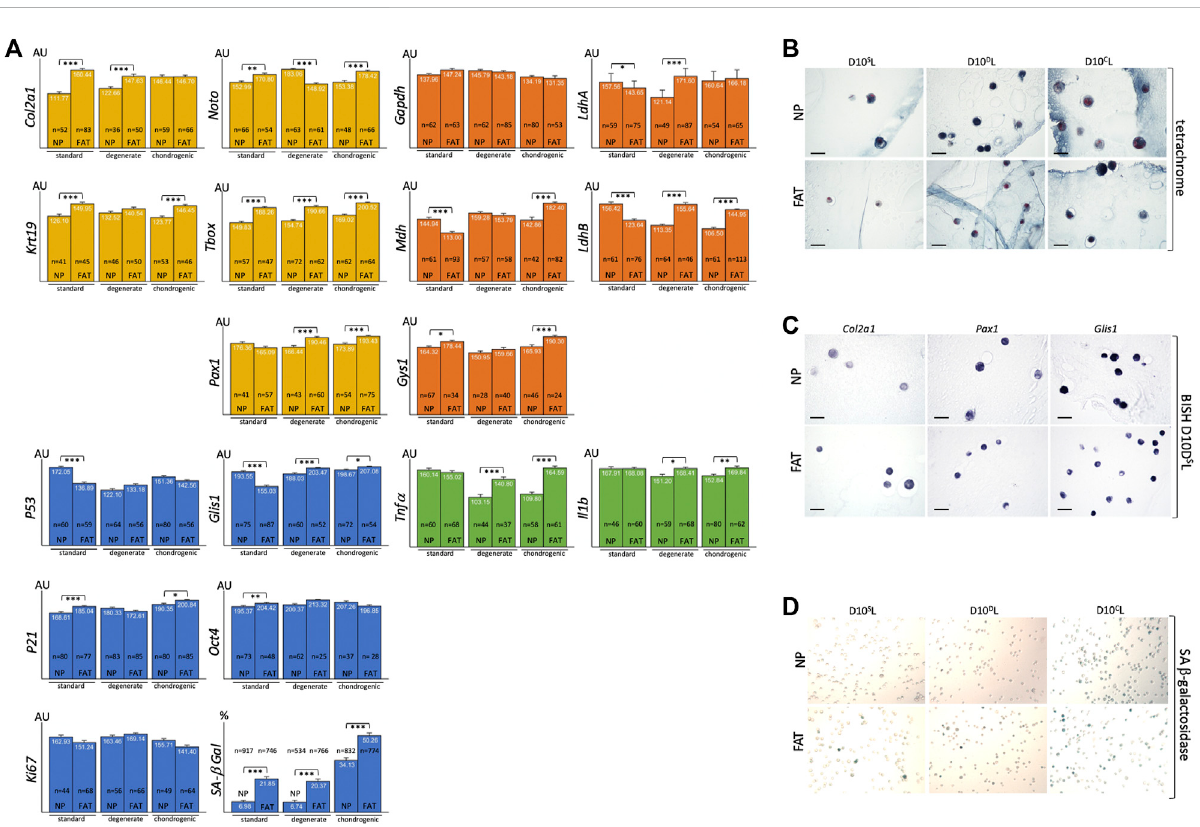
FIGURE 10 Bar graphs indicate RNA levels after BISH and ImageJ analysis of NP and FAT cells after 10 days of 3D alginate bead culture under different culture conditions for genes related to the nucleus pulposus (NP) (yellow), glucose and lactate metabolism (orange), in fl ammatory markers (green), cell proliferation and senescence markers, and SA-beta galactosidase staining (blue). Cells were isolated from a single donor to avoid genotype effects. A minimum of 25 cells were analyzed after subjecting three beads per probe, cell line, and condition to BISH (A) . Tetrachrome-based histology of 7 μ m paraf fi n sections of NP and FAT cells in alginate beads after 10 days of 3D alginate bead culture under different culture conditions showstheroundcellmorphology (B) .Examplesof7 μ mparaf fi nsectionsofNPandFATcellsafter10 daysof3Dalginatebeadcultureunderdifferent cultureconditionsand BISHshowAP-reportergeneactivity for Col2a1 , Pax1 ,and Glis1 expression (C) .Exampleofimagesused foracell count ofNP andFATcellsafter10 daysof3DalginatebeadcultureunderdifferentcultureconditionsandsubjectiontoSA- β -galactosidasestain (D)